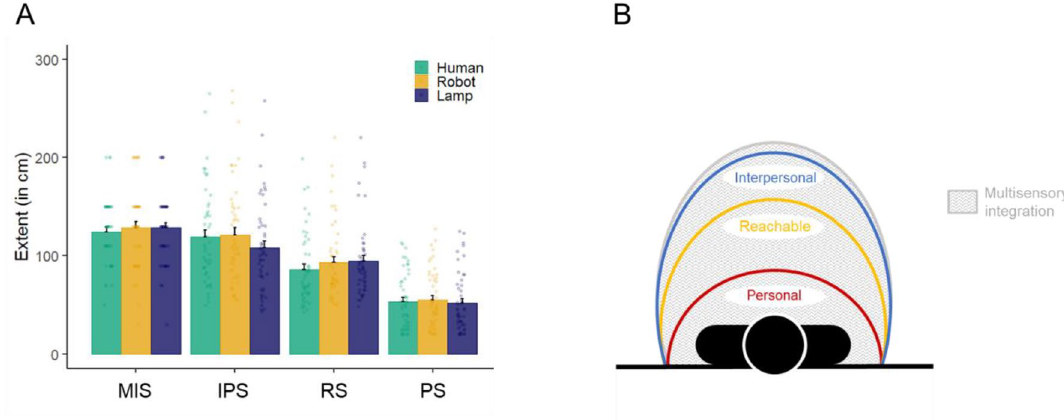
Figure 2. ( A ) The extent of the different spaces (MIS, IPS, RS, PS) expressed in centimetres as a function of the stimulus (human, robot, lamp). The bars represent the average extent (error bars represent the SE), while the dots represent the individual performances. ( B ) Schematic representation of the organisation of the different